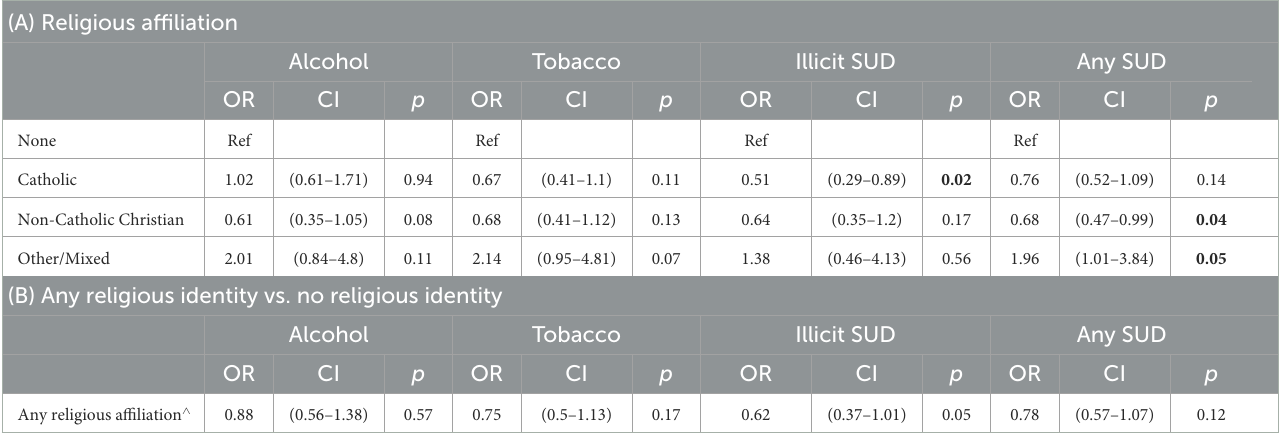
TABLE 3 Religion and substance use ∗ .